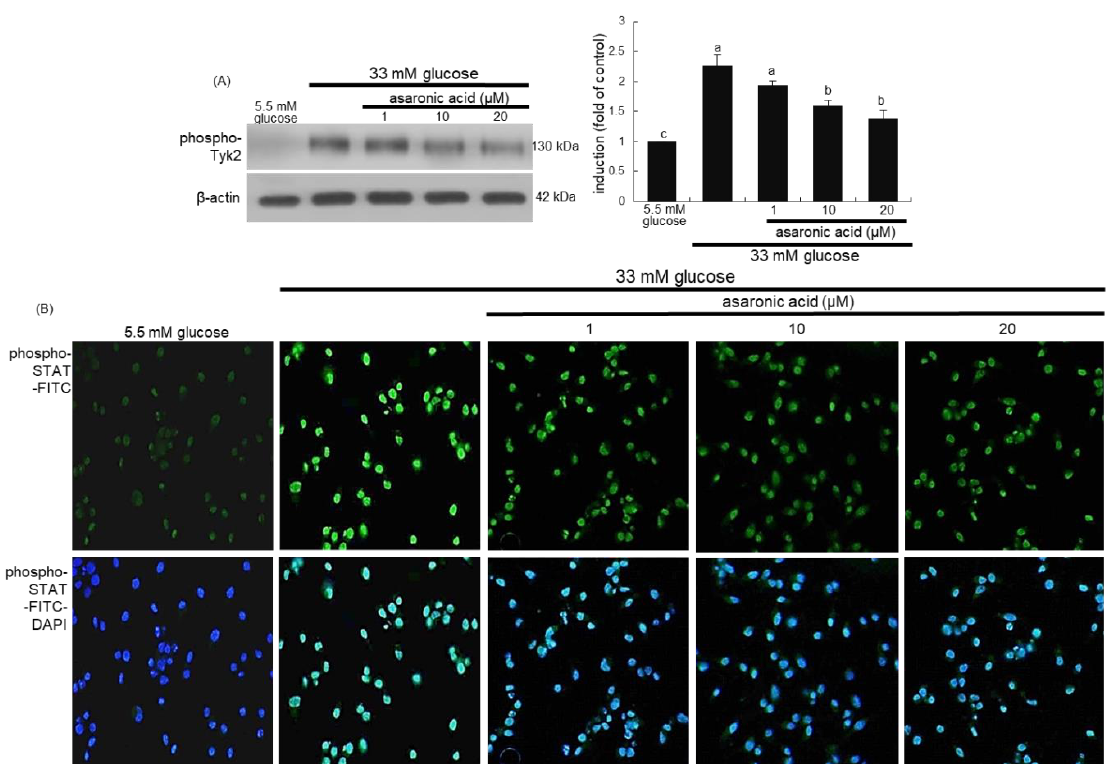
Figure 6. Blockade of induction of phospho-Tyk2 and phospho-STAT6 by asaronic acid. J774A.1 macrophages were exposed to 33 mM glucose in the absence and presence of 1–20 μM asaronic acid for 48 h. Cell lysates were subject to 8–12% SDS-PAGE and Western blot analysis with a primary antibody against phospho-Tyk2 ( A ). β-Actin antibody was used as an internal control. The bar graphs (mean ± SEM, n = 3) in the panels represent quantitative results of the left blot bands obtained from a densitometer. Mean values in respective bar graphs not sharing a same lower-case alphabet letter are significantly different at p < 0.05. Immunocytochemical analysis showing phospho-STAT6 induction in glucose-loaded macrophages ( B ). The phospho-STAT6 localization was confirmed by FITC-green staining in macrophages exposed to 33 mM glucose ( n = 3). Nuclear staining was done with DAPI (blue). Magnification: 200-fold.